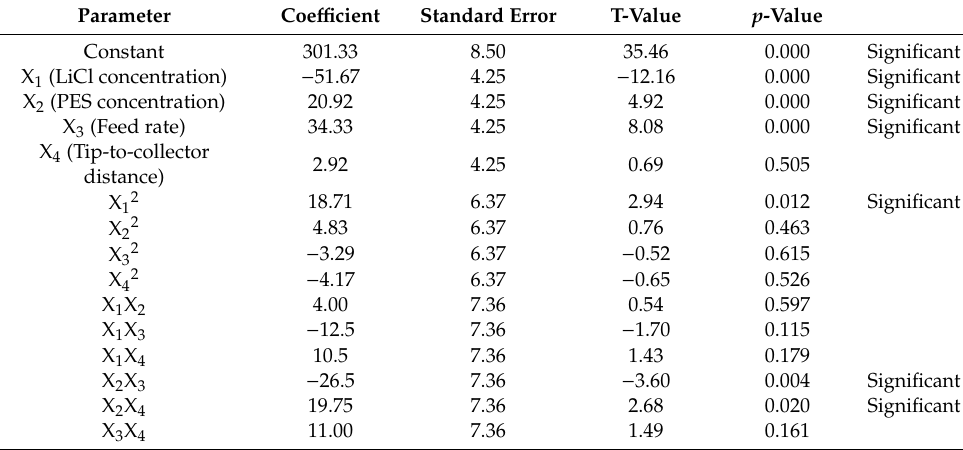
Table 5. The regression analysis in the fitted quadratic polynomial model for the average fiber diameter based on the t-statistic. R 2 = 0.9587, R adj2 =